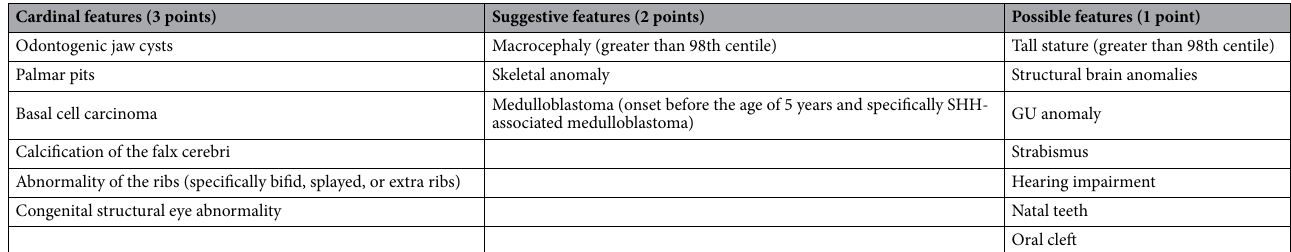
Table 3. Proposed criteria to prompt molecular testing of PTCH1 and SUFU . Molecular testing is suggested if an individual has features that sum to a total of at least six points (e.g. 2 cardinal features, 3 suggestive features, or 1 cardinal feature with 1 suggestive feature and 1 possible feature). Of note, features that are listed in parentheses are suggested for clinical use but were not included in analyses of sensitivity and specificity as they do not all align with HPO